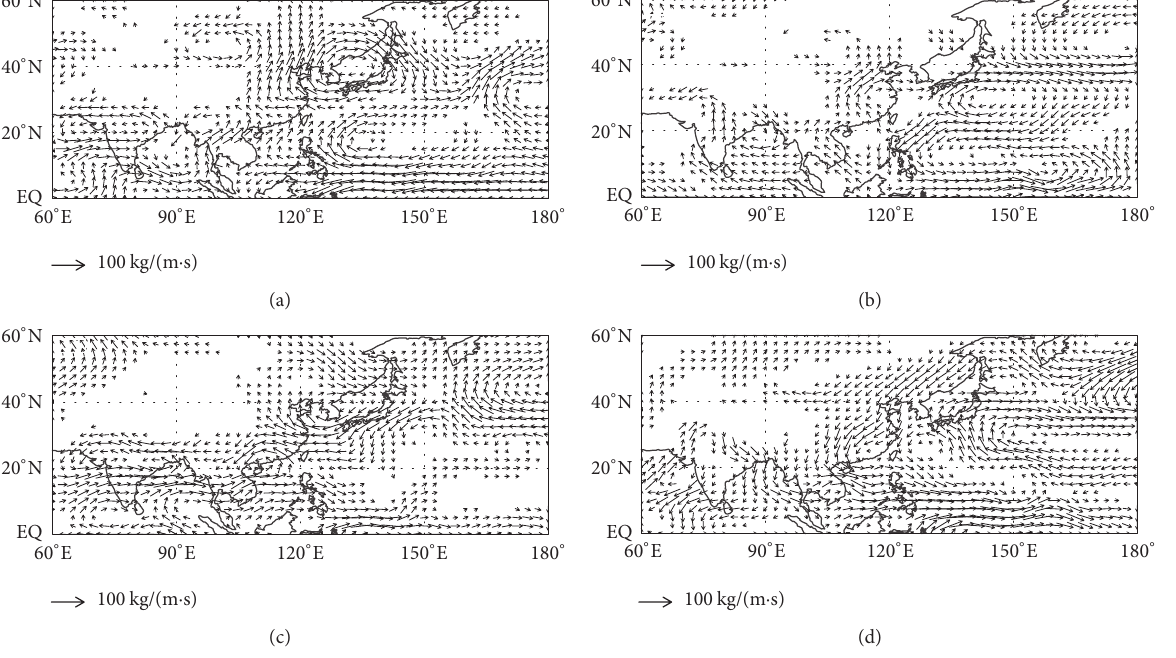
Figure 14: Anomalies of vertically integrated water vapor flux (arrows, units: kg m −1 s −1 ) of the SFND pattern in the summers of (a) 1973, (b) 1976, (c) 1994, and (d)